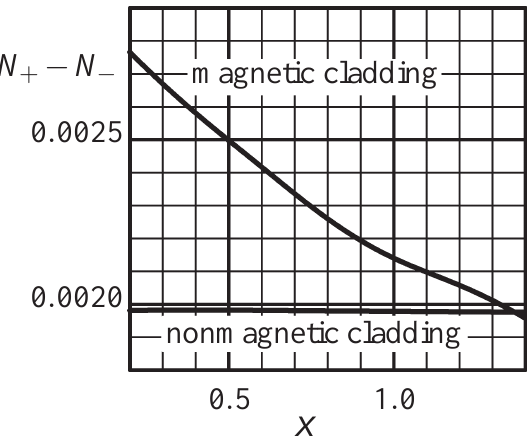
N , for the transverse circular polarizations − ± − is plotted for two x Ga x O 12 , in the cladding. N + − N − − x Ga x O 12 , on the real index −